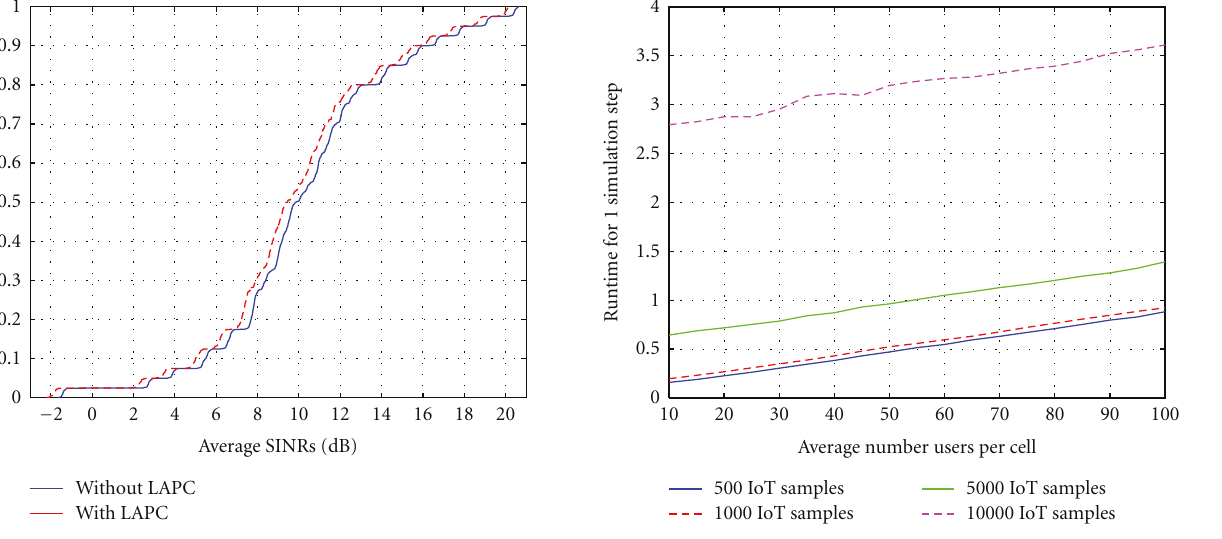
Figure 12: Runtime in a 57-cell environment on a 2.4 GHz